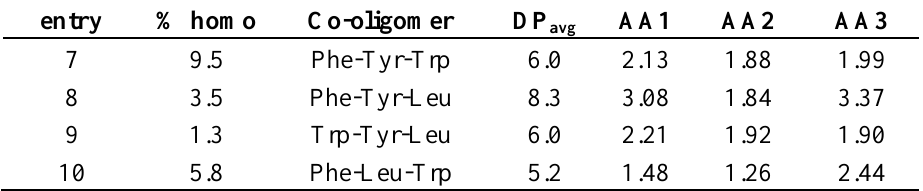
Table 5. Average composition of co-oligomers containing three amino